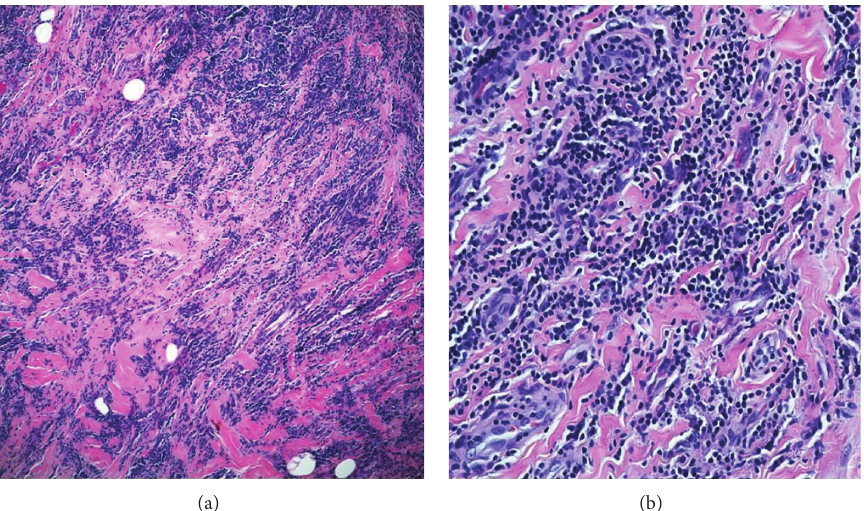
Figure 4: Microscopic low-power (a) and high-power (b) views demonstrating fibrous proliferation (pink staining) and lymphoplasmacytic infiltrate (blue staining), with no cytologic atypia, mitotic activity, or